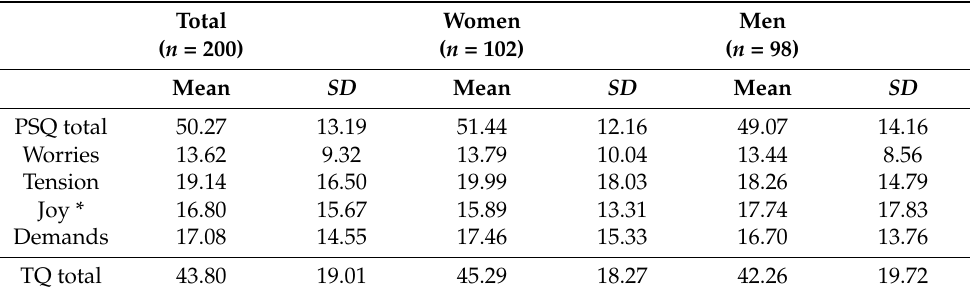
Table 2 features descriptive results for the obtained psychological indices; Table 3 for vascular-metabolic risk factors, and Table 4 for vascular-metabolic blood parameters. Table 2. Means and standard deviations for the psychological